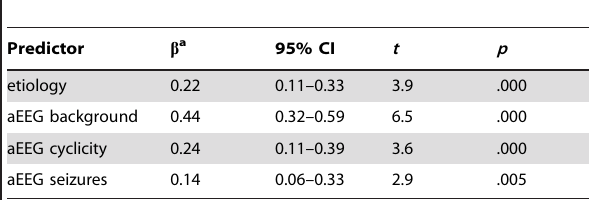
Table 6. Multiple linear regression model for neurodevelopmental outcome (measured as continuous variable of DQ score) by using aEEG features and etiology as predictors.